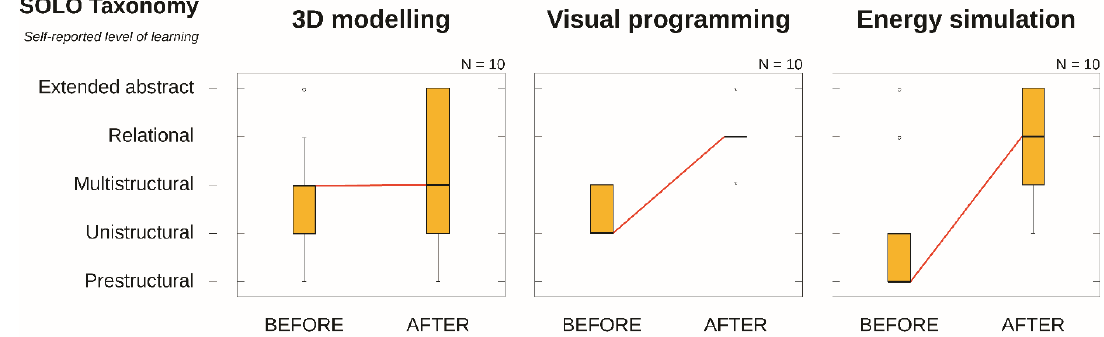
Figure 9. Boxplots for the self-reported level of learning outcomes of C2019, before and after the application of the control method.